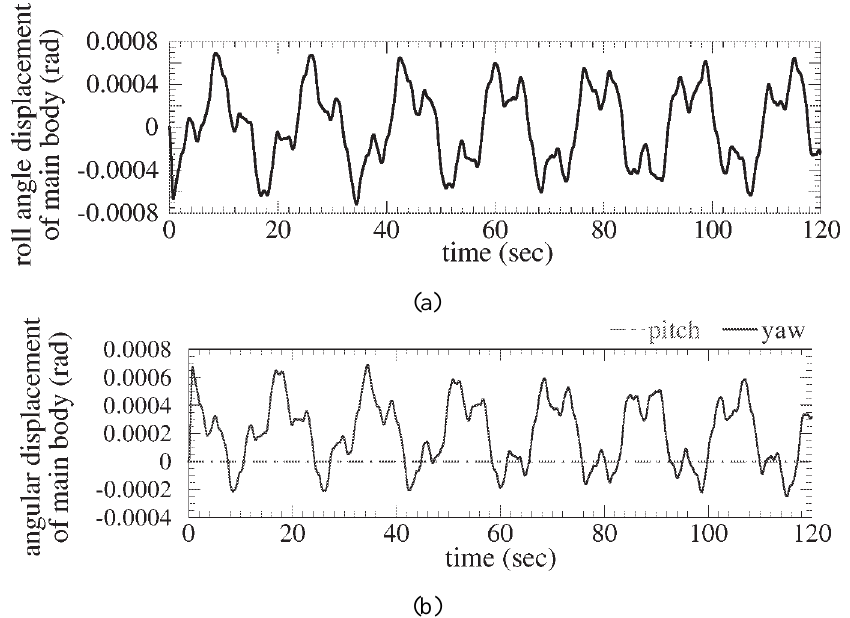
Fig. 7. Time responses of the rigid main body under the bang-bang yaw torque input only: (a) roll angle displacement, (b) pitch and yaw angle